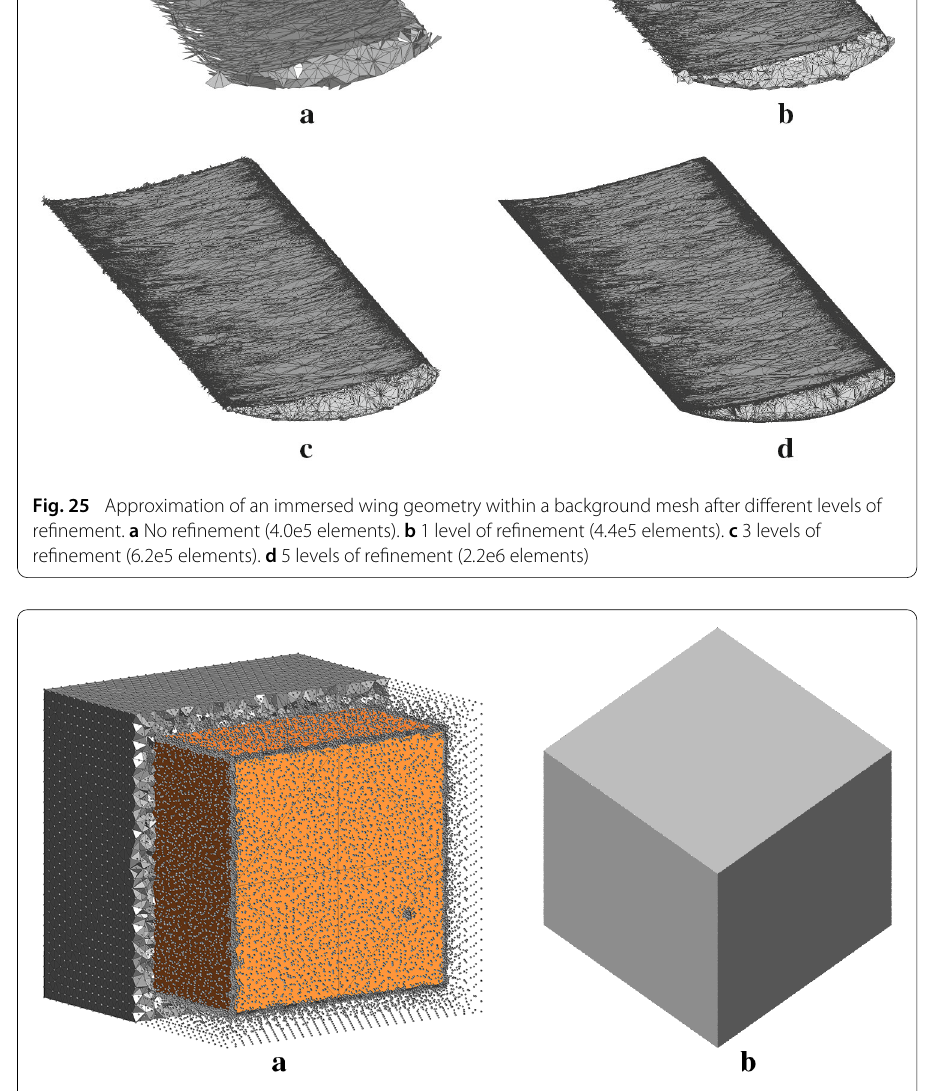
Again note, that only critical regions of the background mesh, i.e., mostly around the cube edges, are refined. Other regions not affecting the approximation quality remain unchanged. Figure 26a visualizes this adaptive refinement by highlighting all nodes of the background mesh. As can be seen from the figure, the originally regular distribution of nodes is interrupted by an accumulation of nodes mostly around the edges. This